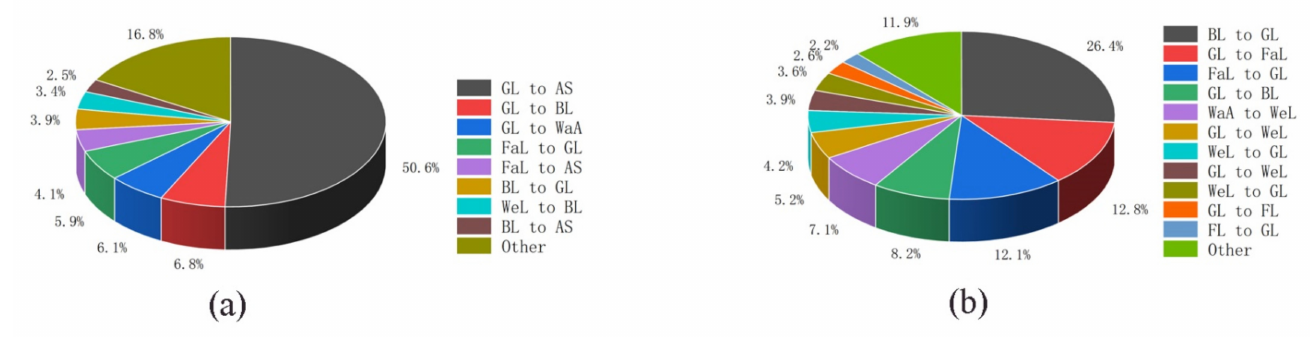
Figure 4. Main land type transformations in areas with significant vegetation changes. ( a ) Significant browning. ( b ) Significant